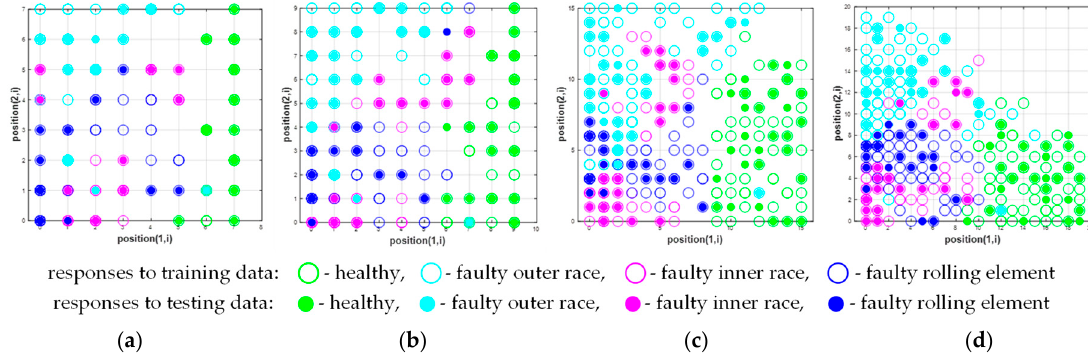
Figure 18. The results of the SOM-based classifier for different sizes of the hexagonal map: 8 × 8 ( a ), 10 × 10 ( b ), 16 × 16 ( c ), 20 × 20 ( d ) with the neighbourhood radius equal to 2 and the linkdist distance function. Table 8. Comparison of the effectiveness of the SOM-based classifier with the neighbourhood radius equal 2 and the linkdist function for various sizes of the hexagonal map.